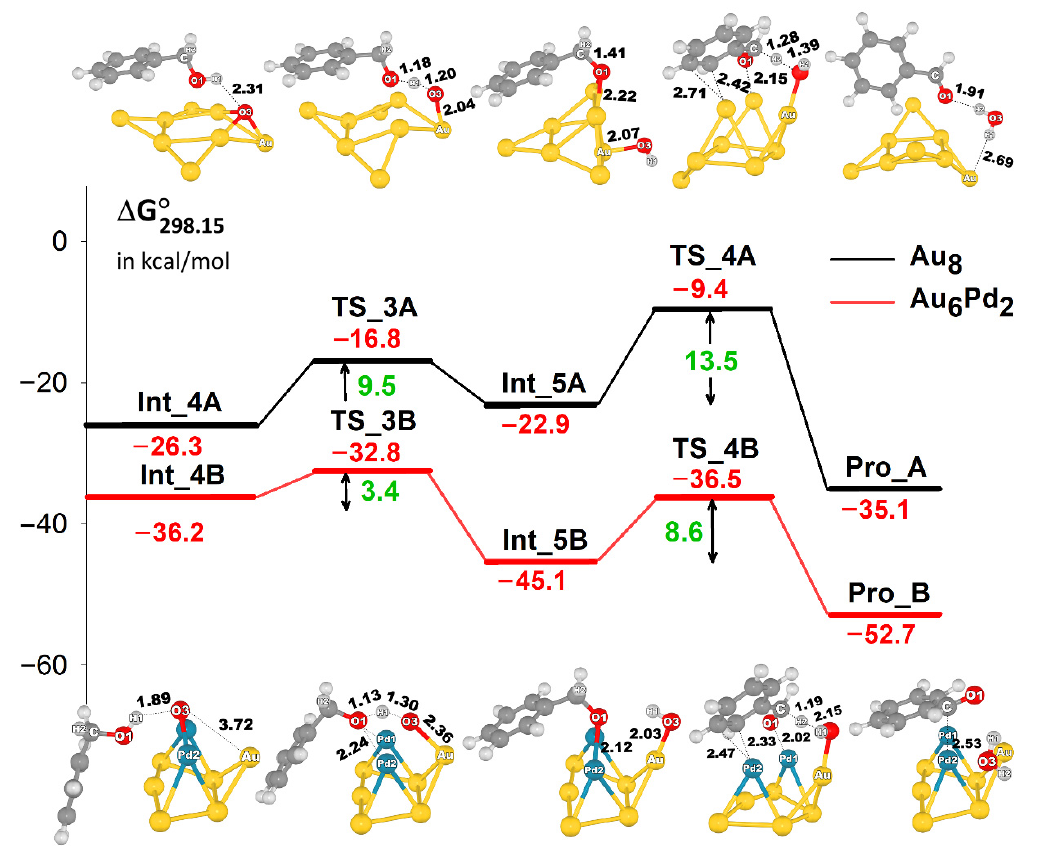
Figure 6. Calculated energy profile and optimized structures for the aerobic oxidation of benzyl alcohol over Au 8 and Au 6 Pd 2 generating benzaldehyde and H 2 O (cont’d). All energy values are shown in kcal/mol and the distances are given in Å.